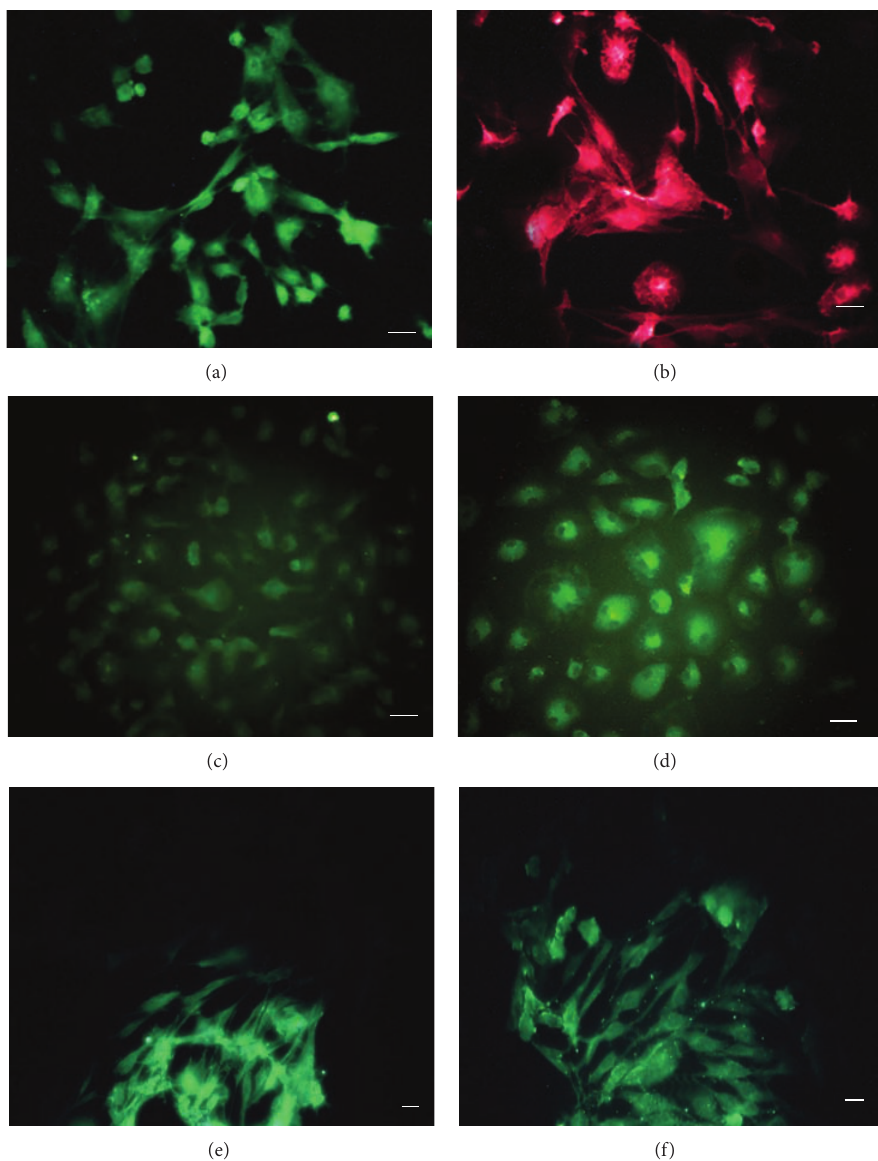
Figure 6: Mesenchymal cells of group 4 underwent immunofluorescent GFAP/Alexa 488 (a), OX-42/TRITC (b), MAP-2/FITC (c), 𝛽 -tubulin III/FITC (d), NeuN/Alexa 488 (e), and NF-200/Alexa 488 (f) antibodies (10x). Scale: 100 𝜇